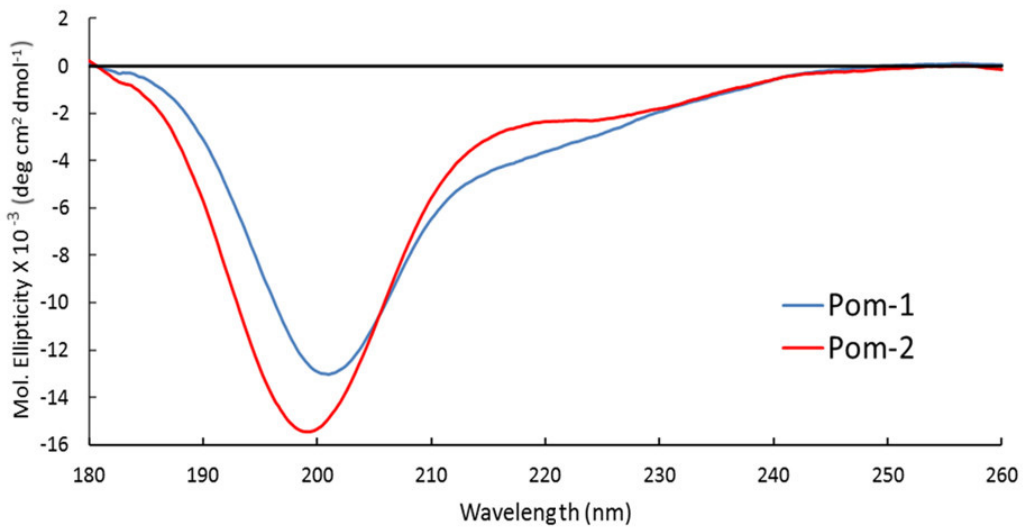
Figure 3. Circular dichroism (CD) spectra of peptides Pom-1 (blue) and Pom-2 (red) at 30 µM concentration in H 2 O. Table 2. Secondary structure content of peptides Pom-1 and Pom-2 in H 2 O.